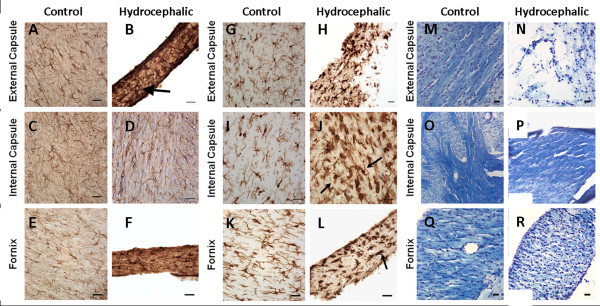
Representative photomicrographs of GFAP (A-F), Iba-1 (G-L), and LFB (M-R) immunohistochemistry of the external capsule, internal capsule, and the fornix of P22/23 control (A, C, & E for GFAP; G, I, and K for Iba-1; M, O, & Q for LFB) and hydrocephalic animals (B, D, & F for GFAP; H, J, & L for Iba-1; N, P, & R for LFB). GFAP staining in the hydrocephalic animals reveals severe reactive astrocytosis when compared to the saline control animals. Panel A shows typical characteristics of resting astrocytes that includes lightly stained cell bodies with thin processes. Panel B demonstrates distinctive characteristics of reactive astrocytes including a darkly stained cell body with thick processes (arrow). For Iba-1, control animals (G, I, & K) exhibit resting microglial cells which are characterized by a small unremarkable cell body with thin processes. The hydrocephalic animals (H, J, & L) display reactive microglia cells which are typified by a darkly stained, enlarged, distorted cell body with thick processes (arrows, J and L). At the end stages of reactivity they exhibit a "balled up" appearance known to represent a phagocytic state (arrow, L). LFB staining is dark and uniform in the saline controls which indicates the preservation of myelin (M, O, & Q). Whereas, the hydrocephalic animals exhibit a more diffuse and variable staining pattern, providing evidence of demyelination most likely resulting from the mechanical stress that accompanies HCP (N, P, & R). Scale bar = 25 μm for all panels except O and P, scale bar = 50 μm.